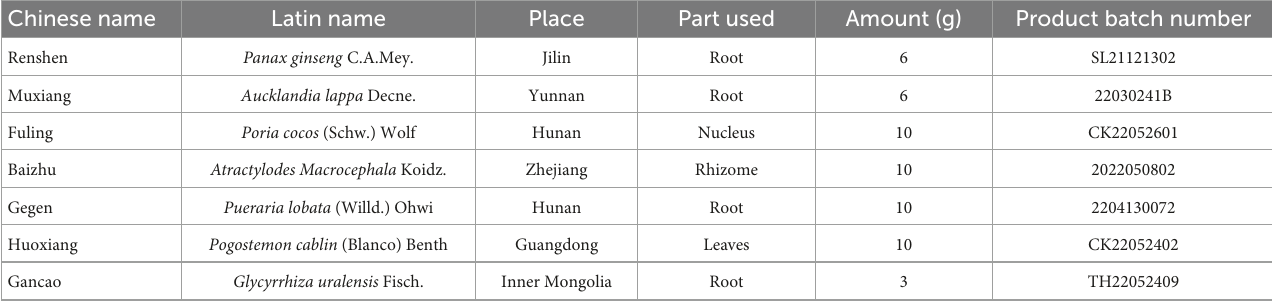
TABLE 2 The ingredients of Qiweibaizhu powder